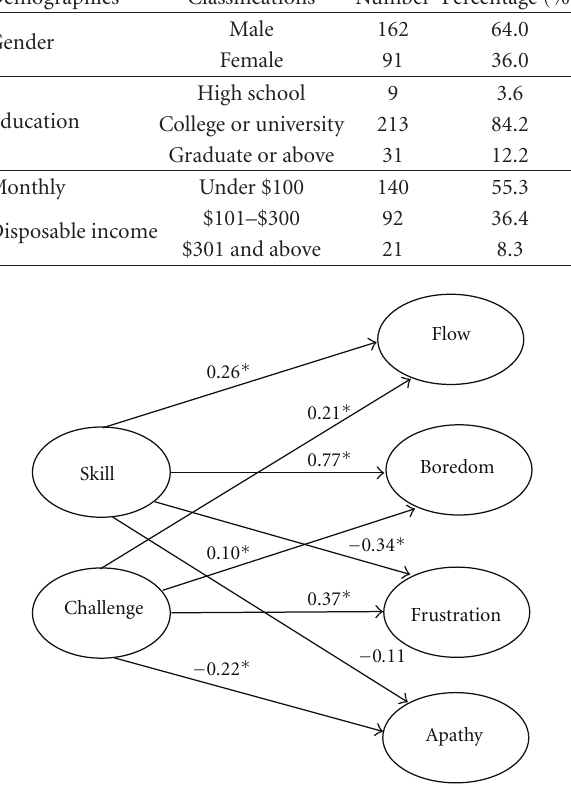
Figure 2: Results of Hypotheses